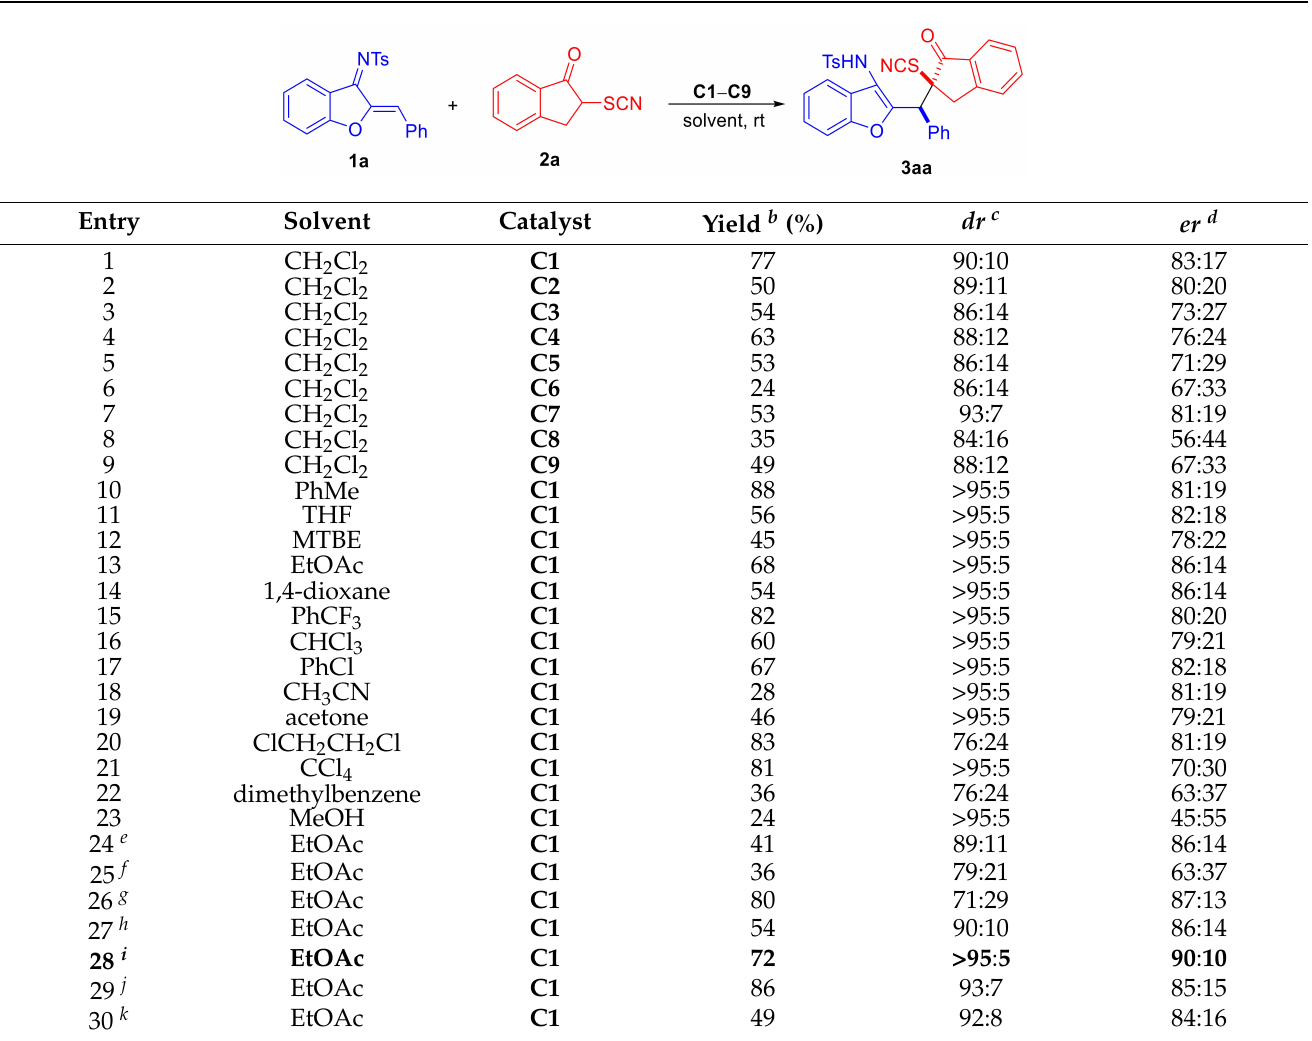
Table 1. Establishment of optimal reaction conditions for azadiene and α -thiocyanoindanone a